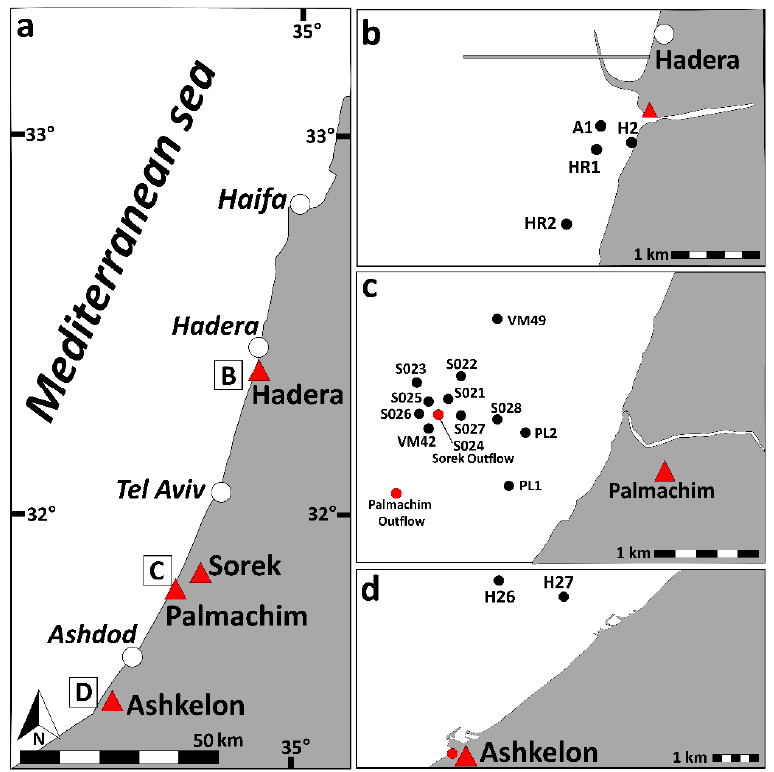
Figure 1. Sampling sites along the Mediterranean Israeli shores. ( a ) A schematic outline of the Israeli Mediterranean shore, indicating the locations of the Ashkelon, Hadera, Palmachim, and Sorek desalination plants. B, C, and D regions (in boxes) are zoomed-in panels ( b – d ), respectively. ( b ) Sam- pling sites near the Hadera desalination plant. ( c ) Sampling sites near the Sorek and Palmachim desalination plants. ( d ) Sampling sites near the Ashkelon desalination plant. ⃝ = a major city; ▲ = desalination plant; ● = sampling site; ● = desalination plant outflow. Distance bars are inserted in each panel. At Hadera and Ashkelon, the outflows are near the seashore line.